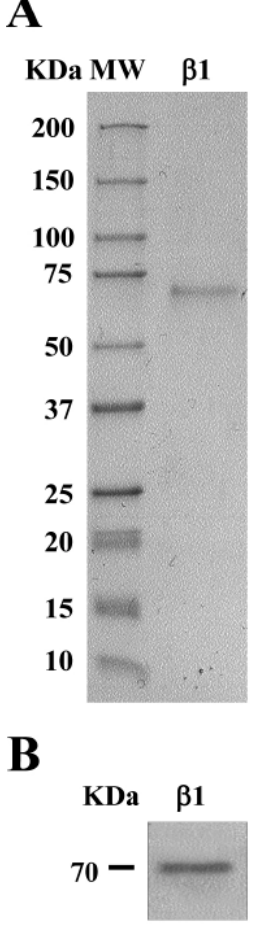
Figure 2. Purification of lupin main allergen β -conglutin (Lup an 1) protein. ( A ) The Coomassie-stained shows the purified β 1-conglutin protein. ( B ) Immunoblotting shows the purified β 1-conglutin protein identified by the anti- β -conglutin antibody. MW, molecular weight standard (kDa).